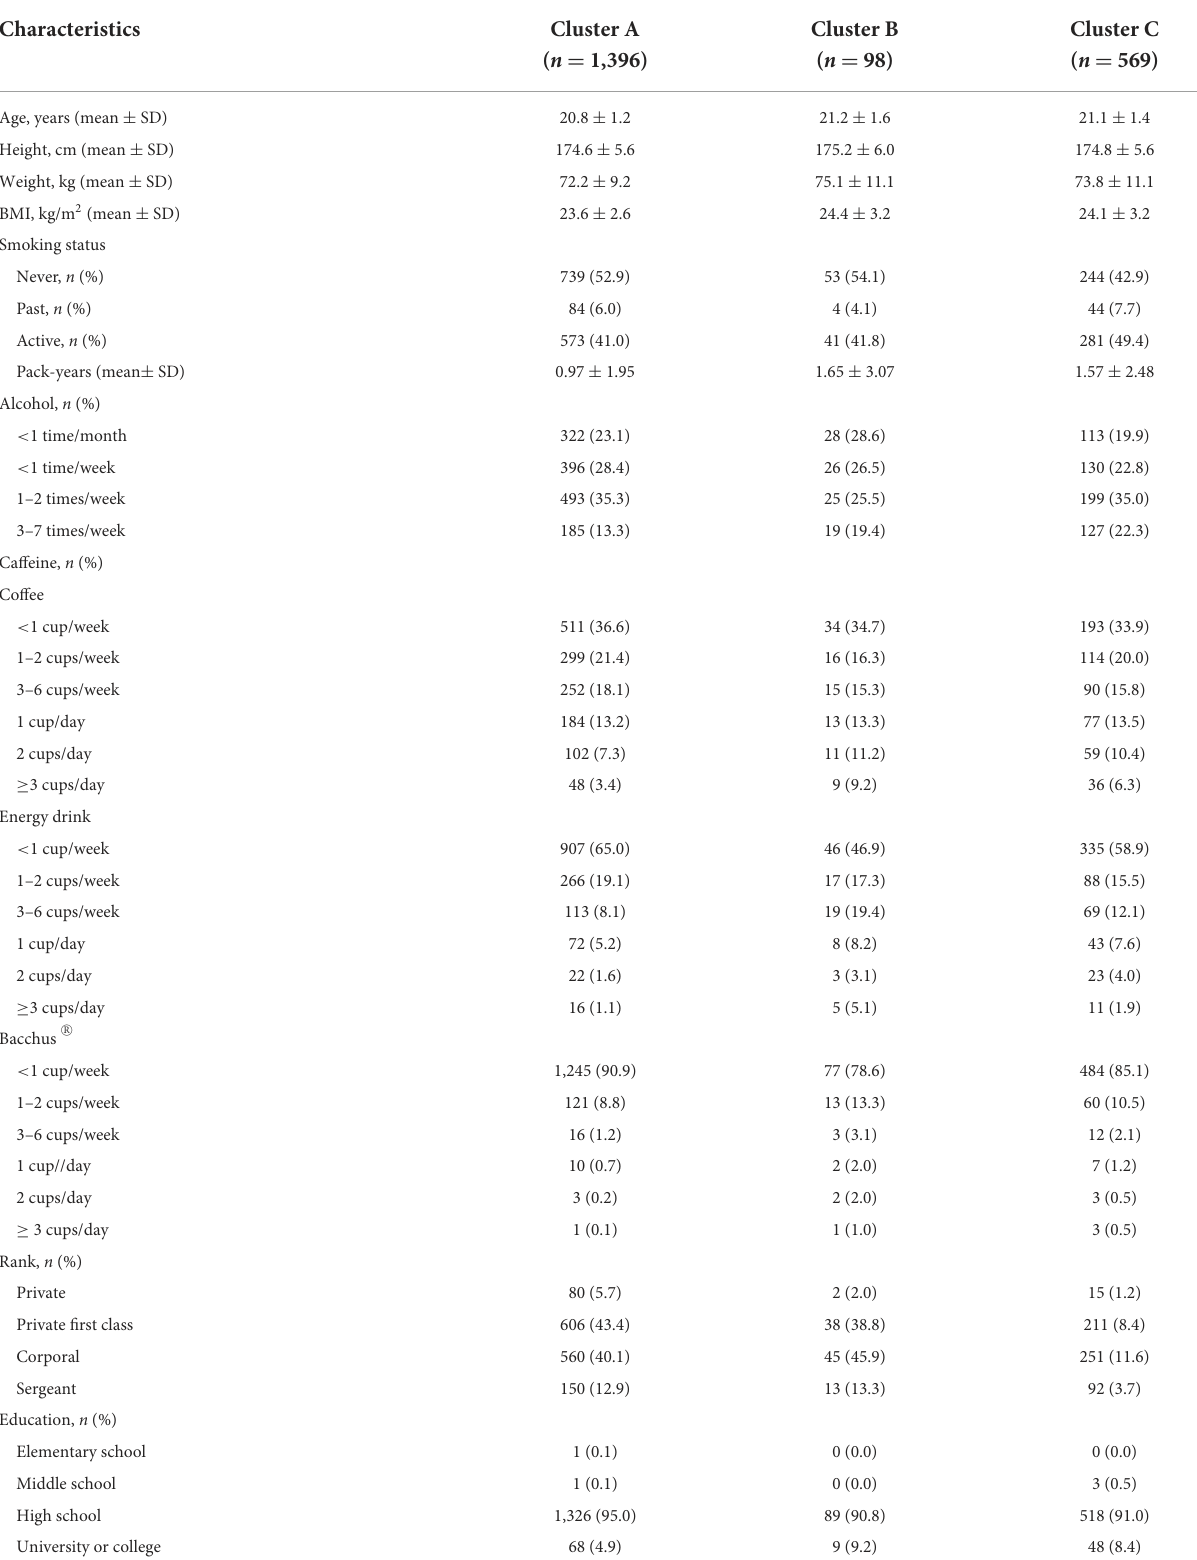
TABLE 2 Patient characteristics in each training set cluster.